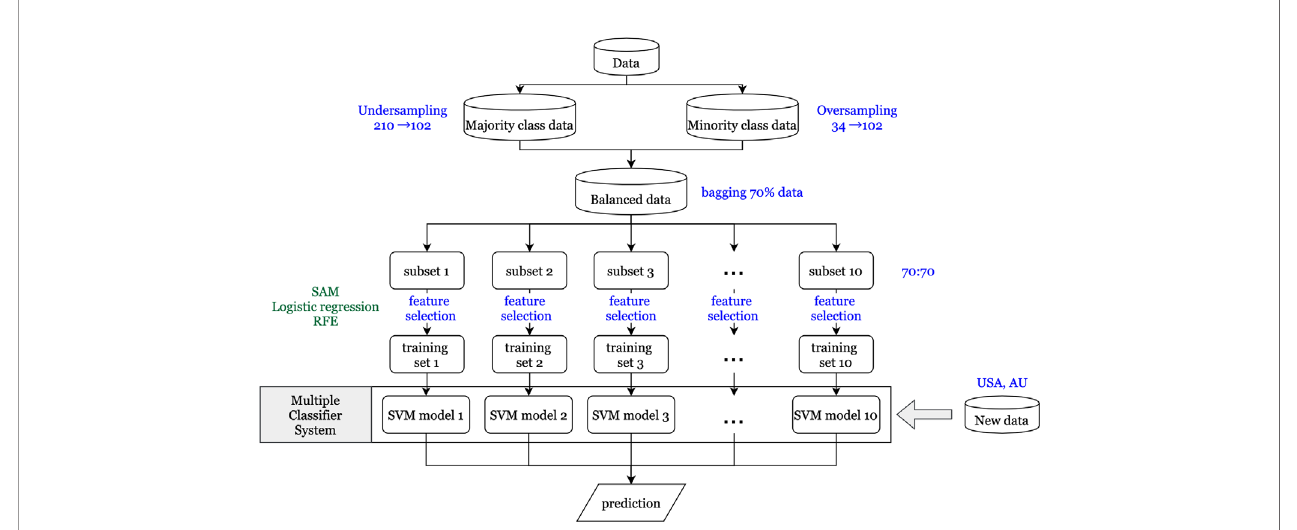
FIGURE 1 | Flowchart for data